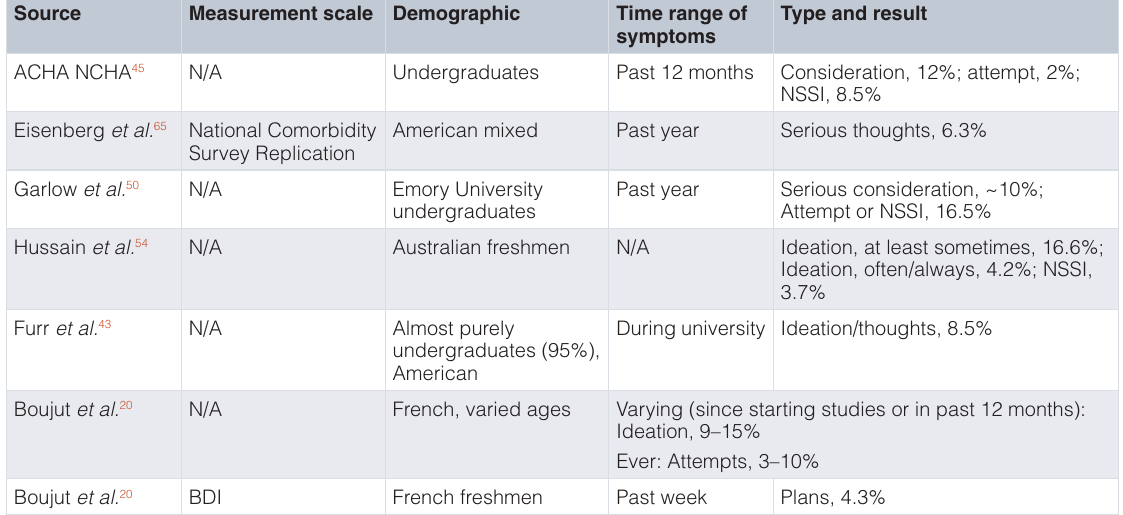
Table 6. Rates of suicidal and self-injurious behaviour among undergraduate and general student samples. Please refer to Table 1 for abbreviations.